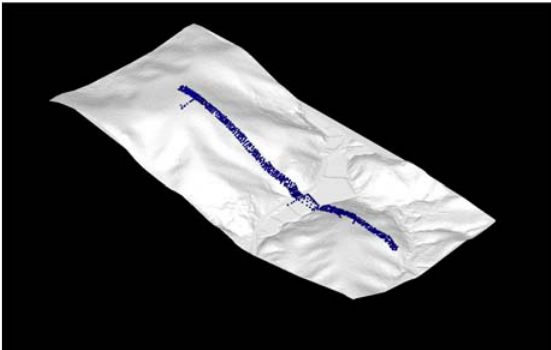
Figure 4. TIN of terrain model and ground truth surveyed points (blue